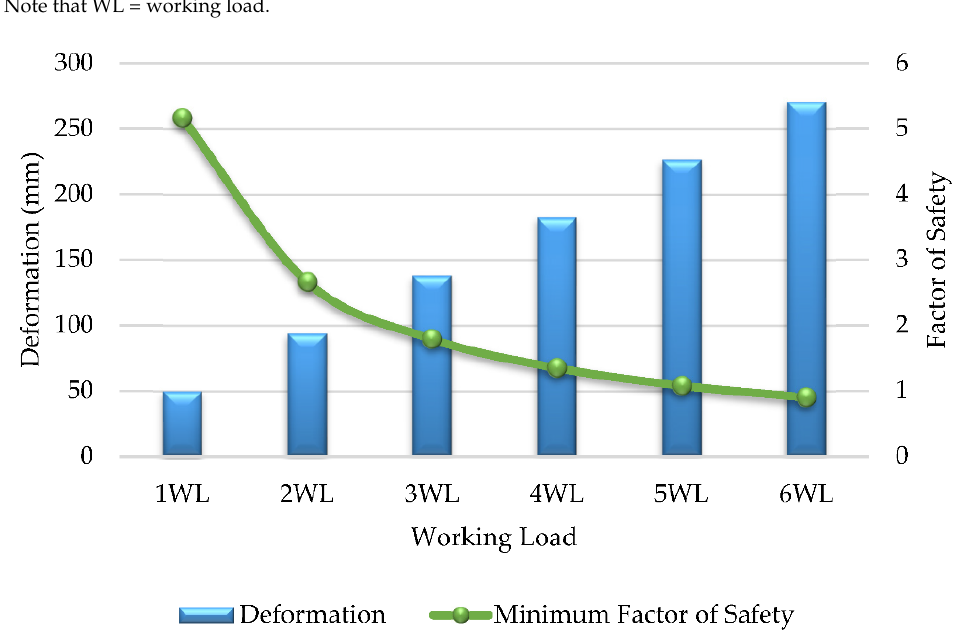
Figure 7. Deformation and Factor of Safety (FOS) for GFRP cross ‐ arm (Normal condition).